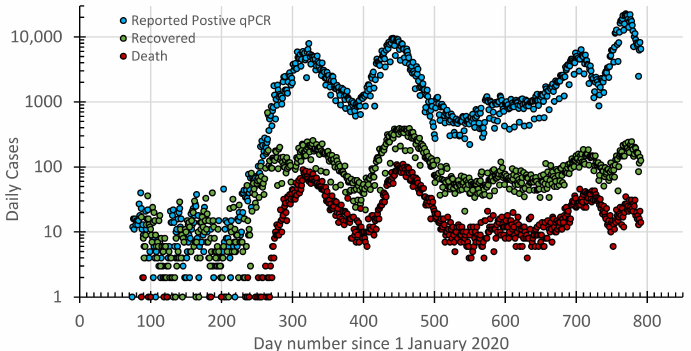
Figure 1. Timelines for the reported daily cases of +qPCR tests, those recovered, and deaths